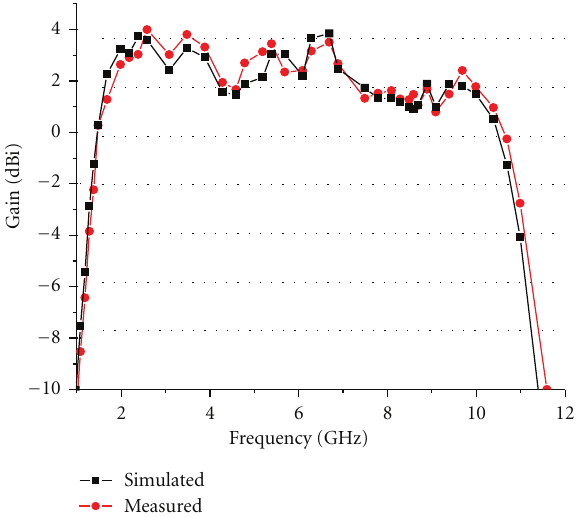
Figure 9: Gain versus frequency of the proposed antenna with both slots (A) and (A (cid:2)